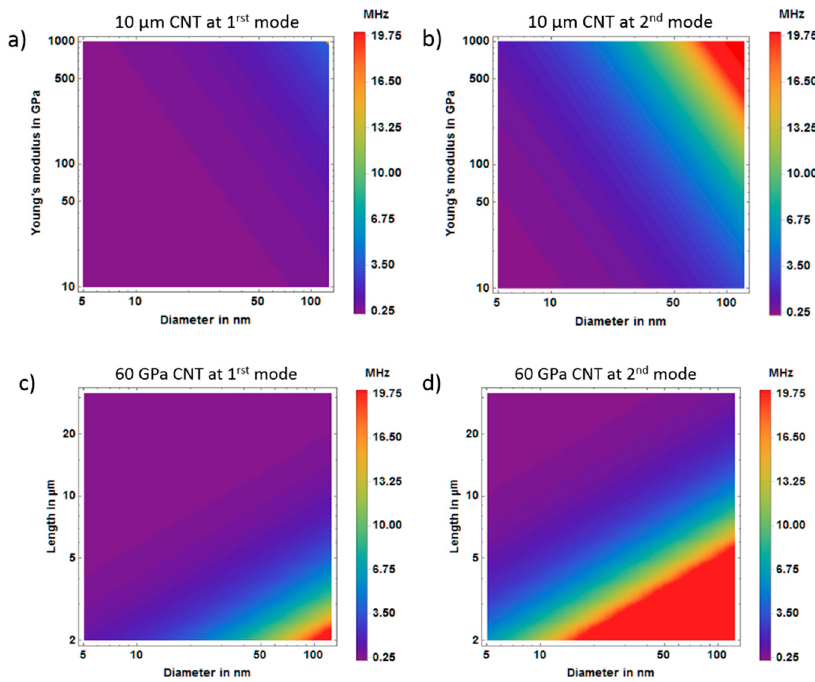
Figure 5. Examples of the theoretical estimations for the resonance frequency ranges of the carbon nanotubes. The color spectrum shows the range of resonance frequencies and Young’s modulus E Y for carbon nanotubes (CNTs) 10 µm long at: ( a ) first and ( b ) second modes; and resonance frequency ranges for CNTs with a predefined bending modulus of 160 GPa at: ( c ) first and ( d ) second modes ( d ).